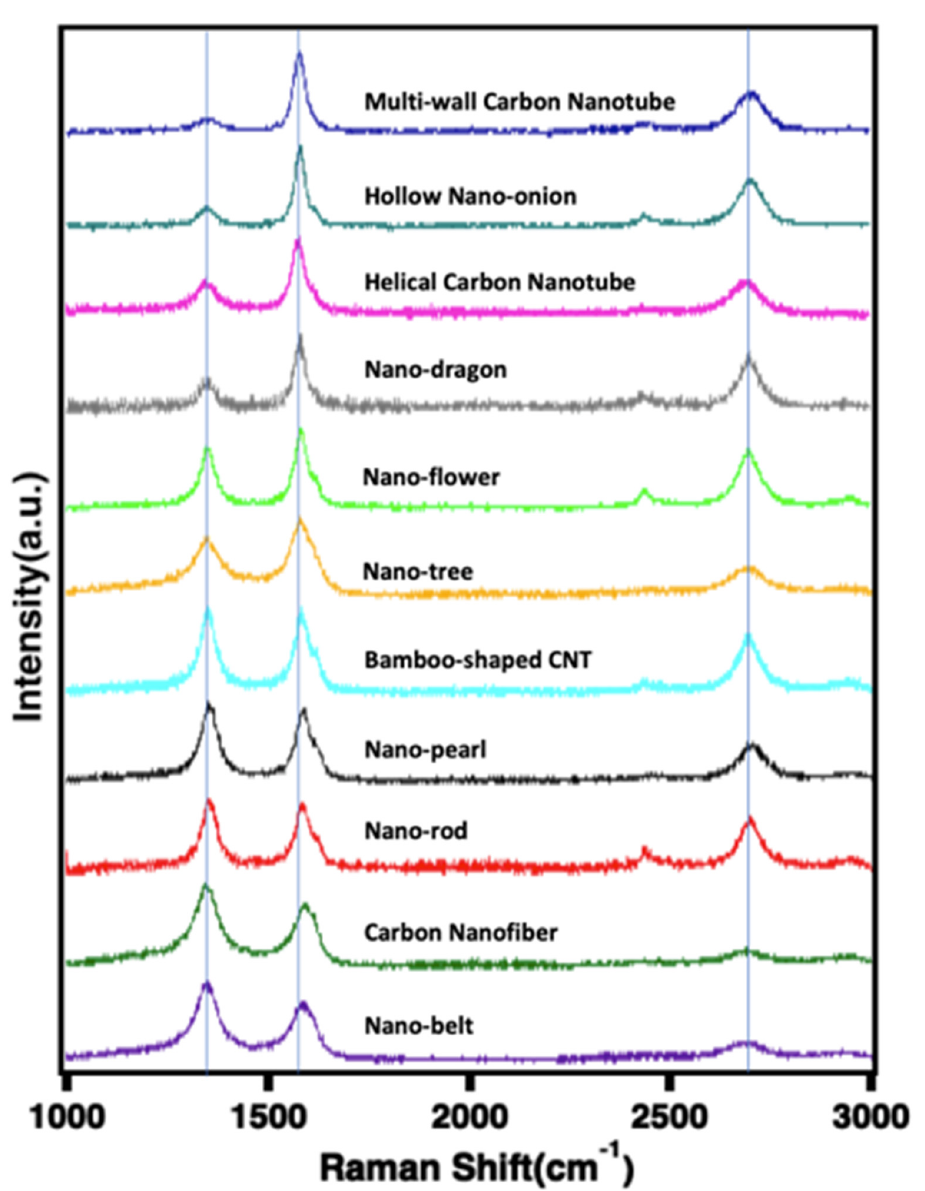
Figure 15. Raman of the synthesis product consists of various labeled CNMs and packed carbon nanotube assemblies synthesized by the electrolytic splitting of CO 2 in 770 °C Li 2 CO 3 with a variety of systematically varied electrochemical conditions.